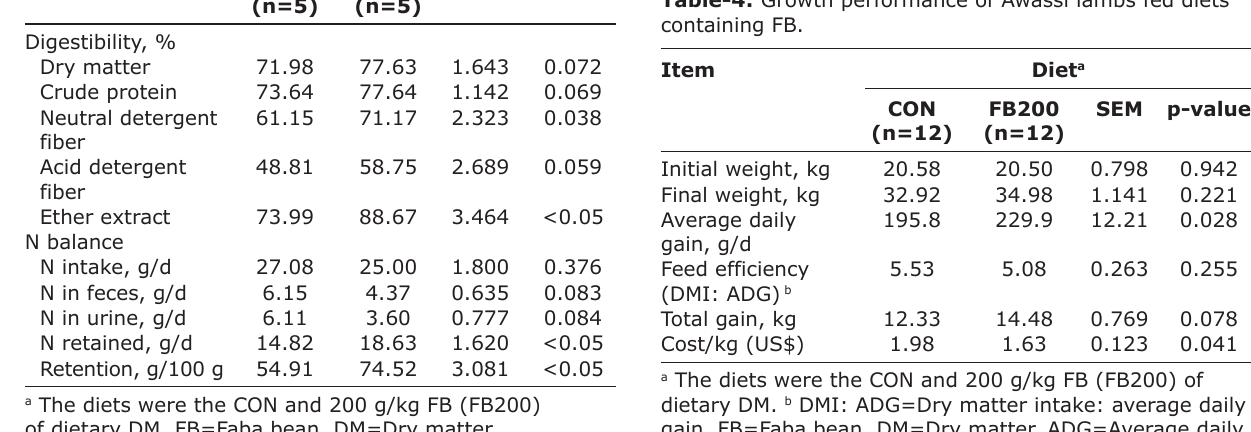
Table-3: Effects of feeding FB on nutrient digestibility and N balance of Awassi lambs. Item